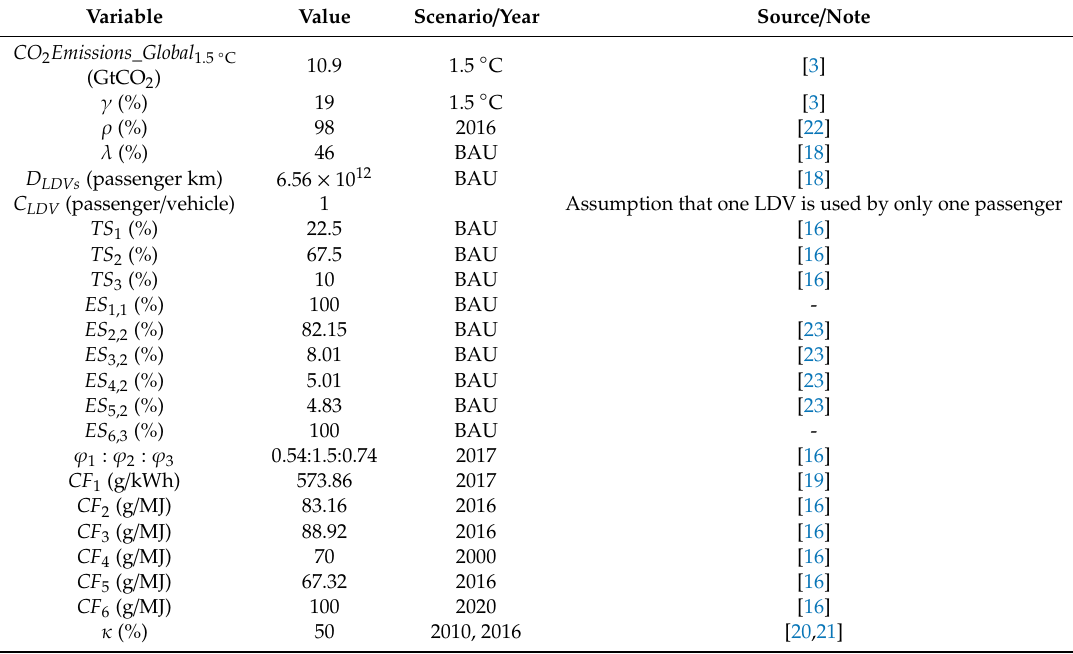
Table 1. Data used to obtain energy consumption limit of active suspension. BAU, business as usual; LDV, light-duty